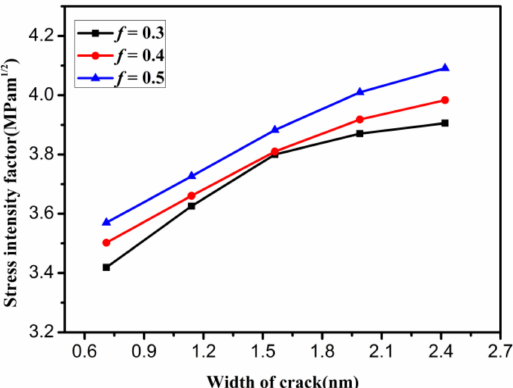
Figure 10. The influence of crack width on the mode I critical stress intensity factor.